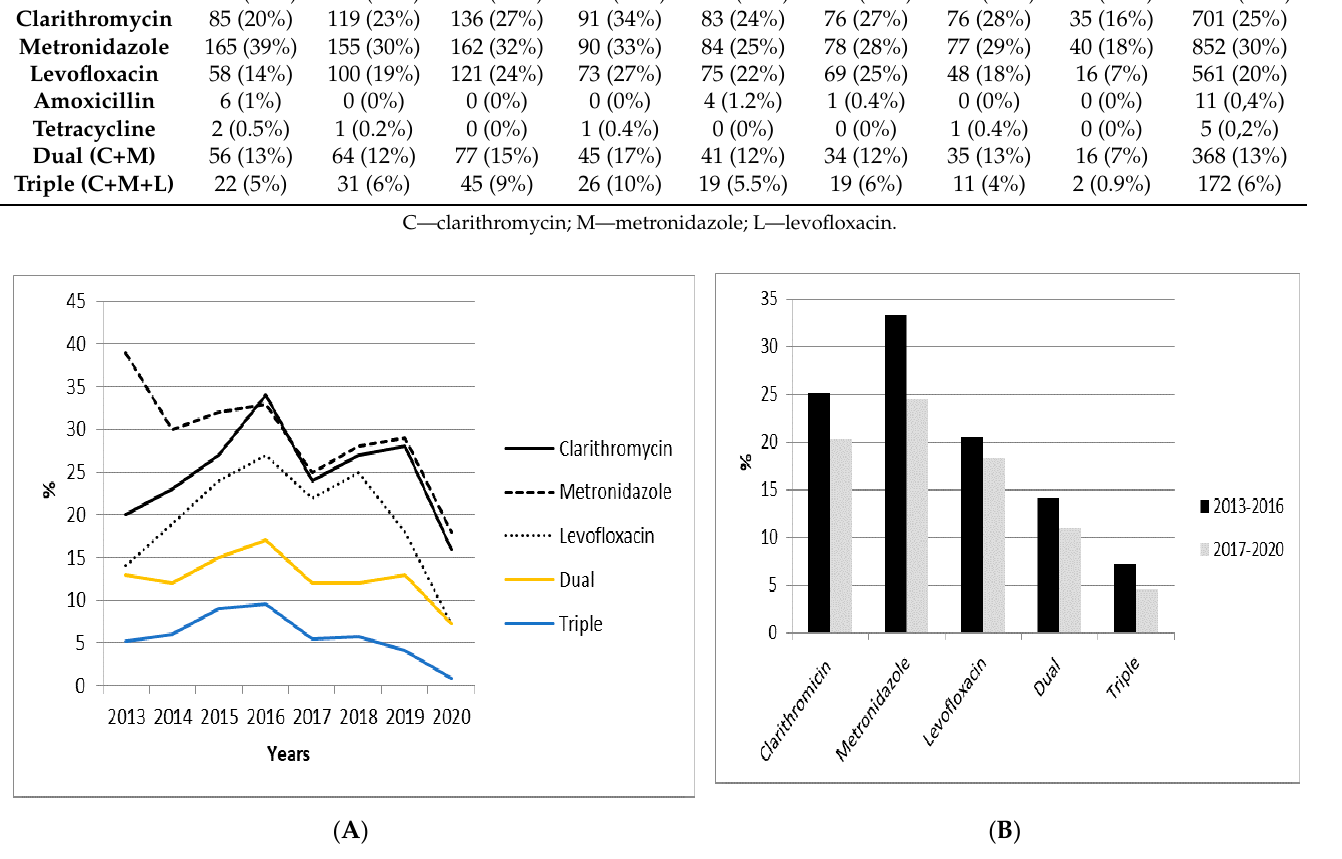
Figure 2. Evolution of Helicobacter pylori antibiotic resistance in naïve patients over the past eight years ( A ) and according to study periods: 2013–2016 and 2017–2020 ( B ).